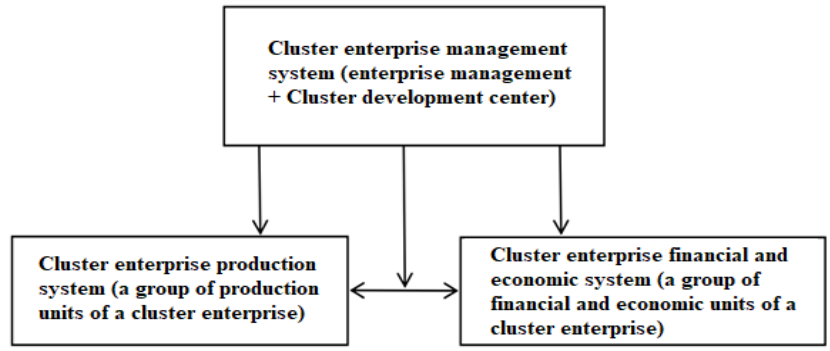
Figure 1. Basic systems of the cluster enterprise according to the functional-target approach. Devel- oped by Izmalkova I. oped by Izmalkova